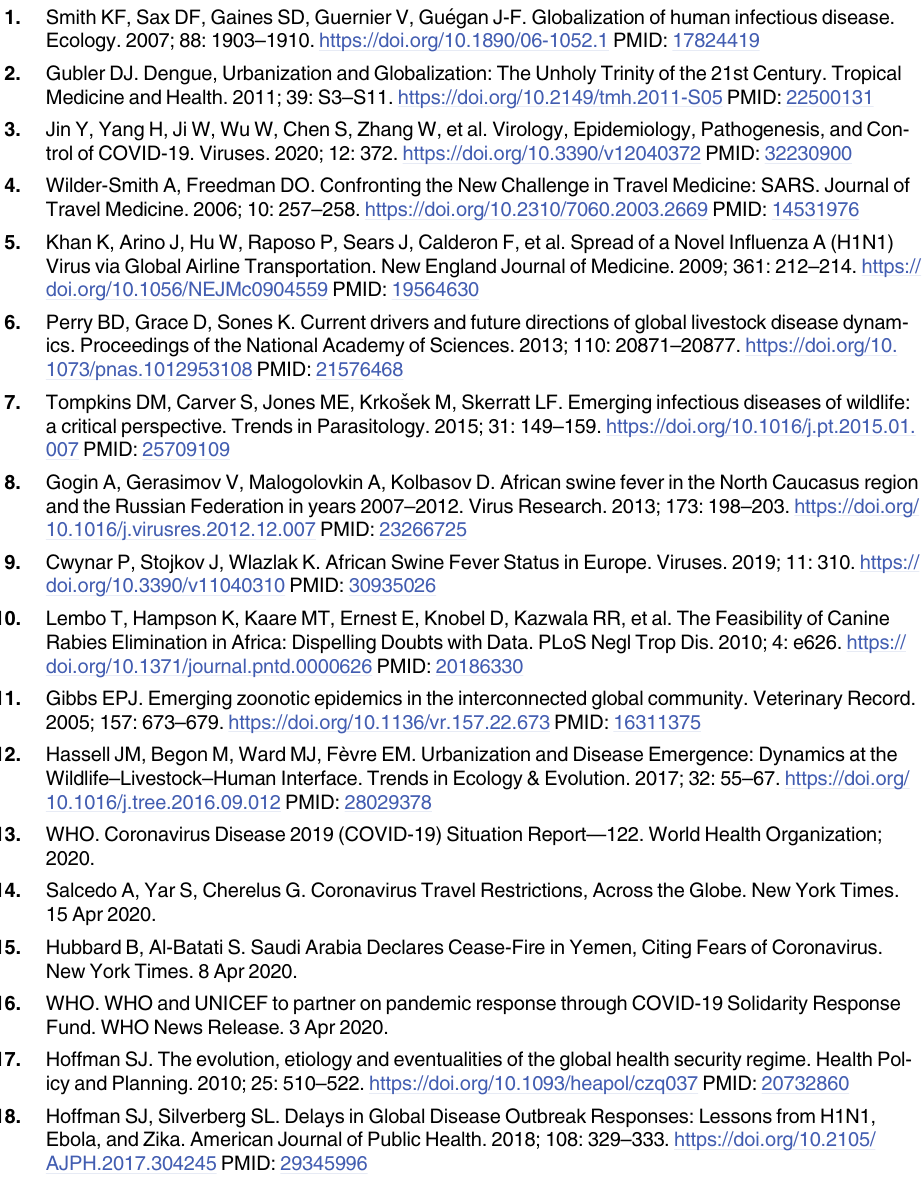
S3 Fig. The probability of establishment with a 50-box Erlang-distributed EIP. Mosquito birthrate = 1/life span and increases from the top to bottom panels, while EIP increases left to right. Here, we constructed an Erlang-distributed EIP by splitting the exposed compartment into 50 separate boxes. Within each panel, the total population size of mosquitoes (in two pop- ulations) and primates (in two populations) changes horizontally and vertically, respectively. For each parameter set, we simulated the introduction of a single infected primate and subse- quent transmission for a three-year period. Blue indicates no simulations establishing, whereas red indicates all simulations establishing. Contour lines show 0.25, 0.5, 0.75, and 0.95 probabil- ity of establishment. EIP, extrinsic incubation